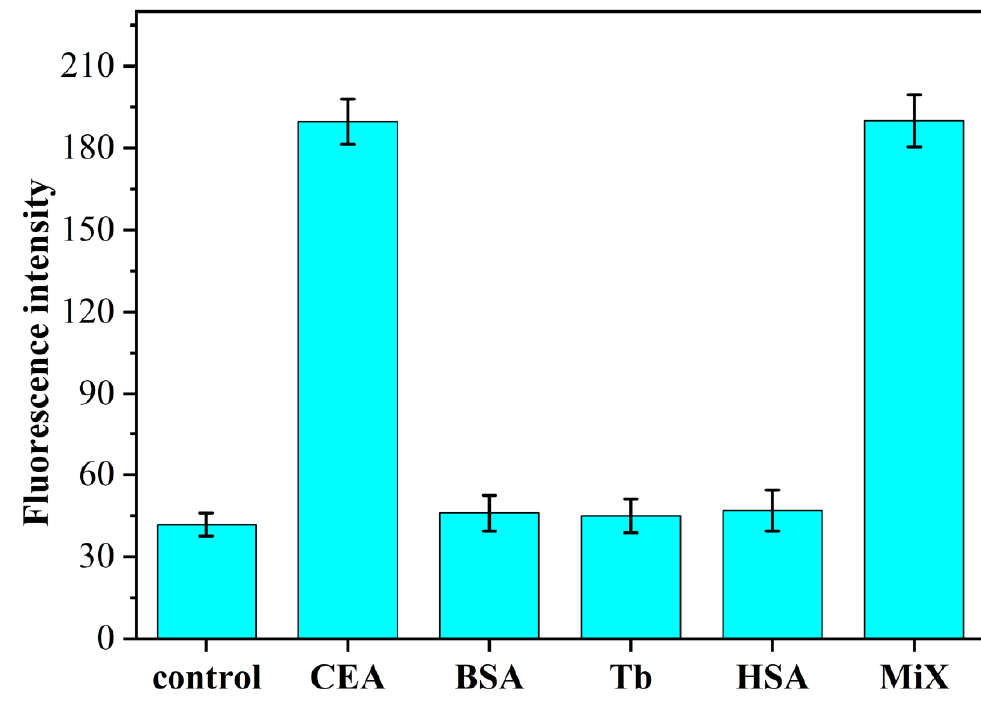
Figure 5. Fluorescence spectrum of H/primer-3/KF/Nb.BbvCI/MB sensor system with CEA specific detection (CEA: 1.0 pg/mL; BSA, Tb and HAS: 1.0 ng/mL).